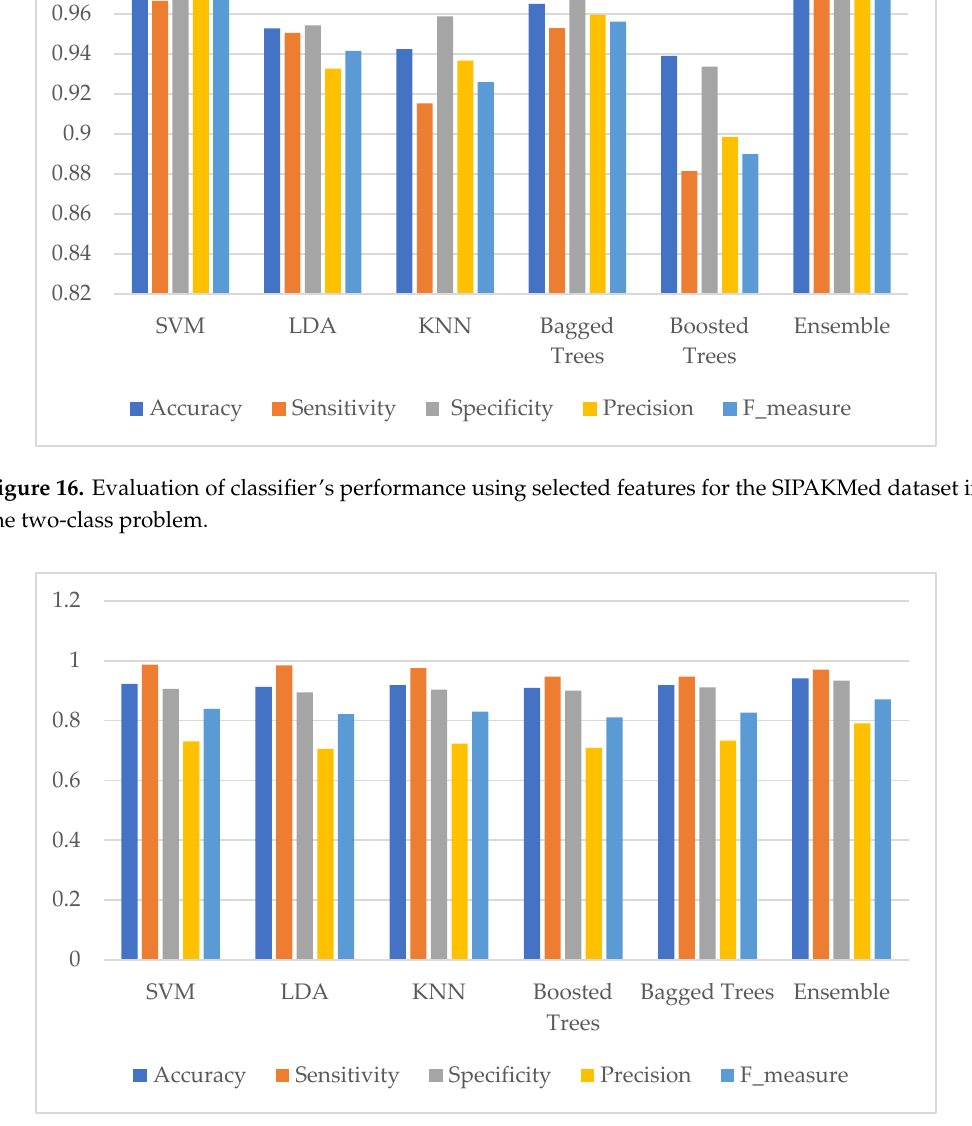
Figure 17. Evaluation of classifier’s performance using selected features for the SIPAKMed dataset in the five-class problem.